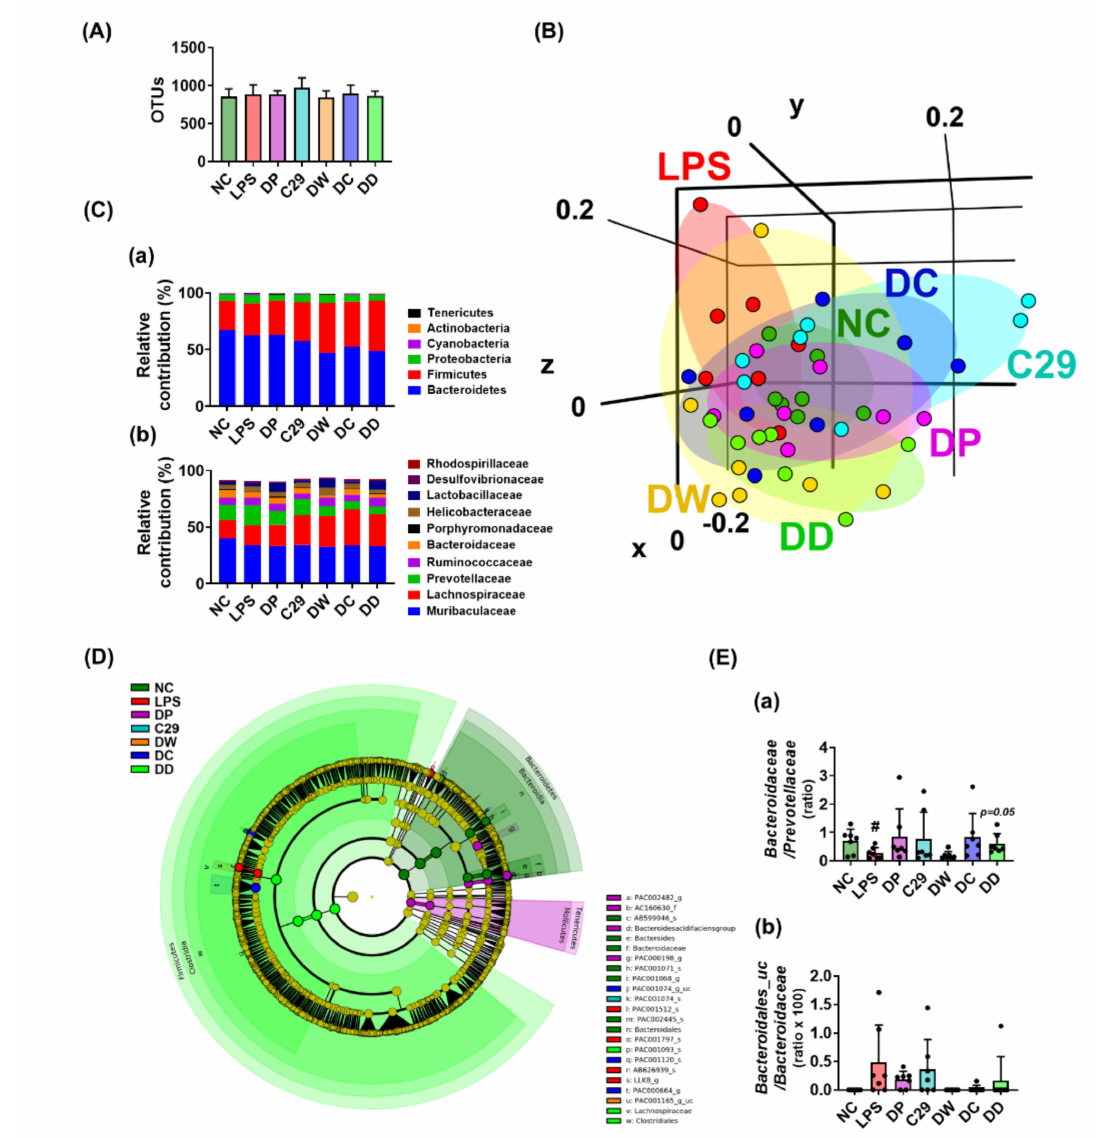
Figure 4. C29, DW2009, donepezil, and their mixtures modulated gut microbiota composition in mice with LPS–induced cognitive impairment. ( A ) Effects on α -diversity (OTUs). ( B ) Effects on β -diversity (principal coordinate analysis (PCoA) plot based on Bray Curtis). ( C ) Effect on the composition of gut microbiota: ( a ) at the phylum level and ( b ) at the family level. ( D ) Effects on the gut microbiota composition, described by Cladogram. ( E ) Effects on the ratio of Bacteroidaceae to Prevotellaceae population ( a ) and Bacteroidales_uc to Bacteroidaceae population ( b ). LPS was intraperitoneally injected in mice daily for 5 days. NC was treated with saline instead of LPS. Test agents (NC, vehicle [saline] alone; LPS, vehicle; DP, 1.5 mg/kg/day of donepezil; C29, 1 × 10 9 CFU/mouse/day of C29; DW, 100 mg/kg/day of DW2009; DC, 1.5 × 10 9 CFU/mouse/day of C29 plus 1.5 mg/kg/day of donepezil; and DD, 100 mg/kg/day of DW2009 plus 1.5 mg/kg/day of donepezil) were orally gavaged in mice once a day for 5 days. The behaviors were measured 24 h after the final treatment with test agents. Data values are as mean ± SD ( n = 7). # p < 0.05 vs. NC